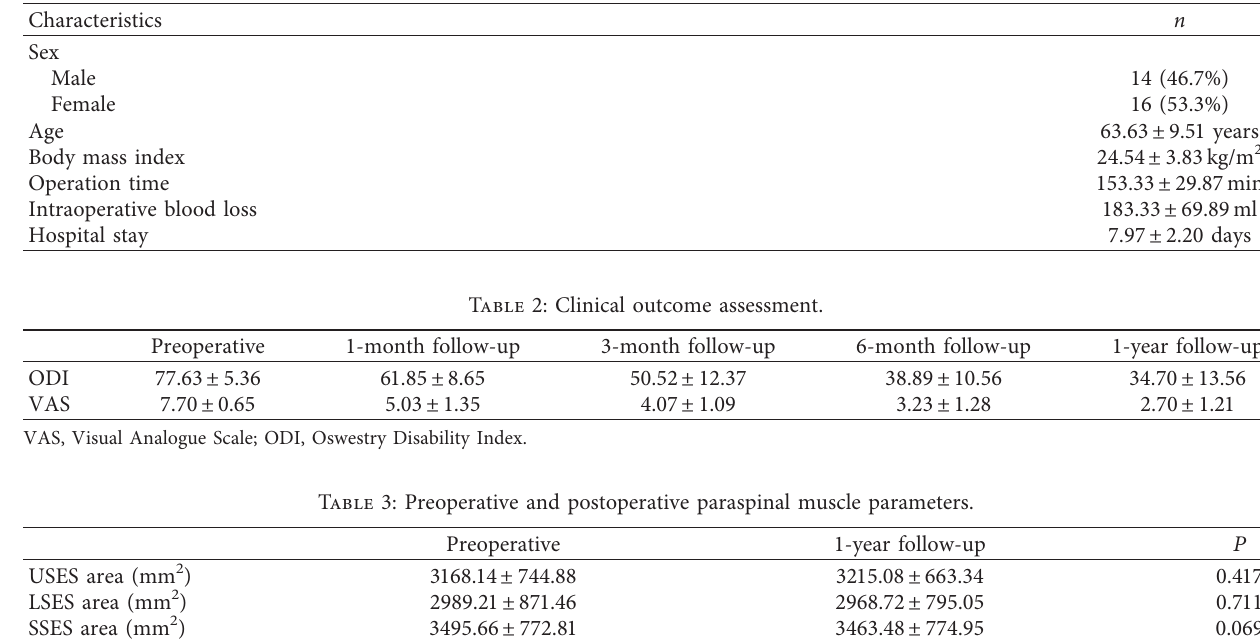
Table 1: Characteristics of patients with lumbar disease in this series.